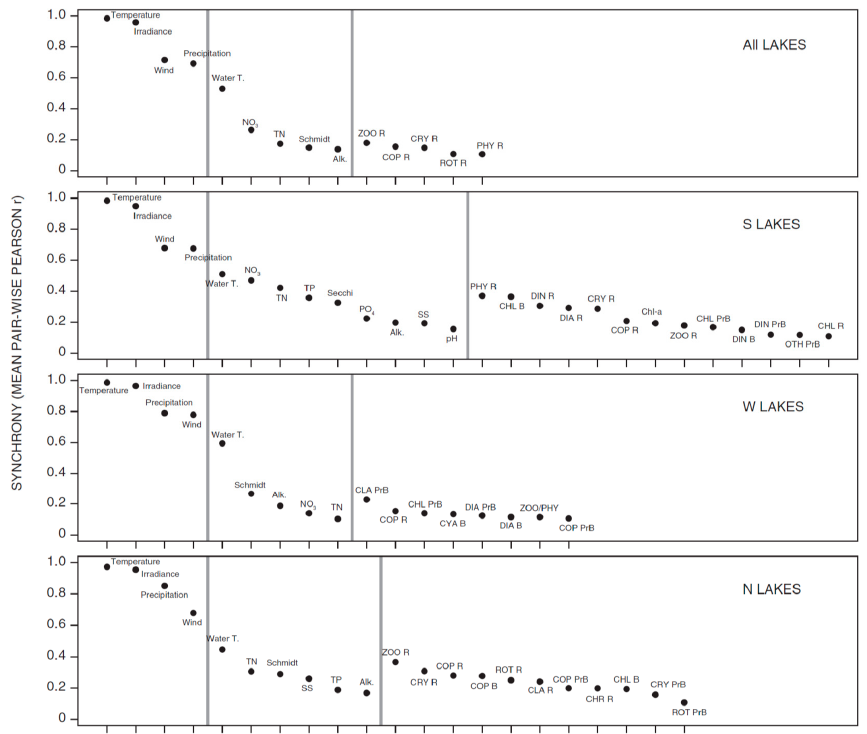
Figure A4. Summary of synchrony in climate, lake and plankton variables in autumn analysed for all lakes and for S, W and N lakes separately. For details see Figure 3.